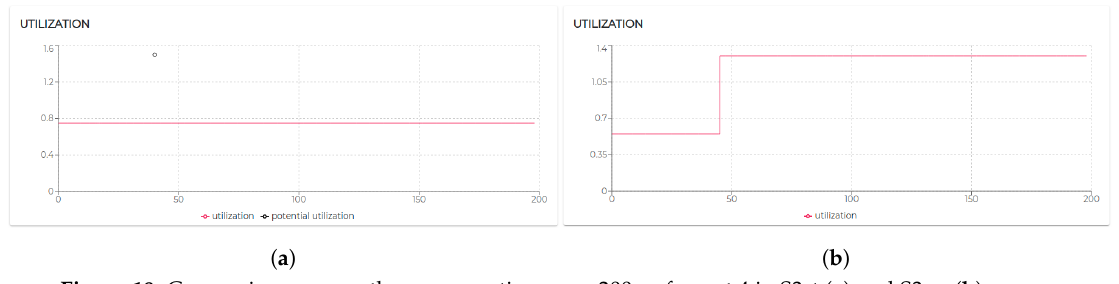
Figure 18. Comparison among the response time over 200 s of agent 4 in S3rt ( a ) and S3gp ( b ); y-axes: utilization (adimensional); x-axes: time (seconds).